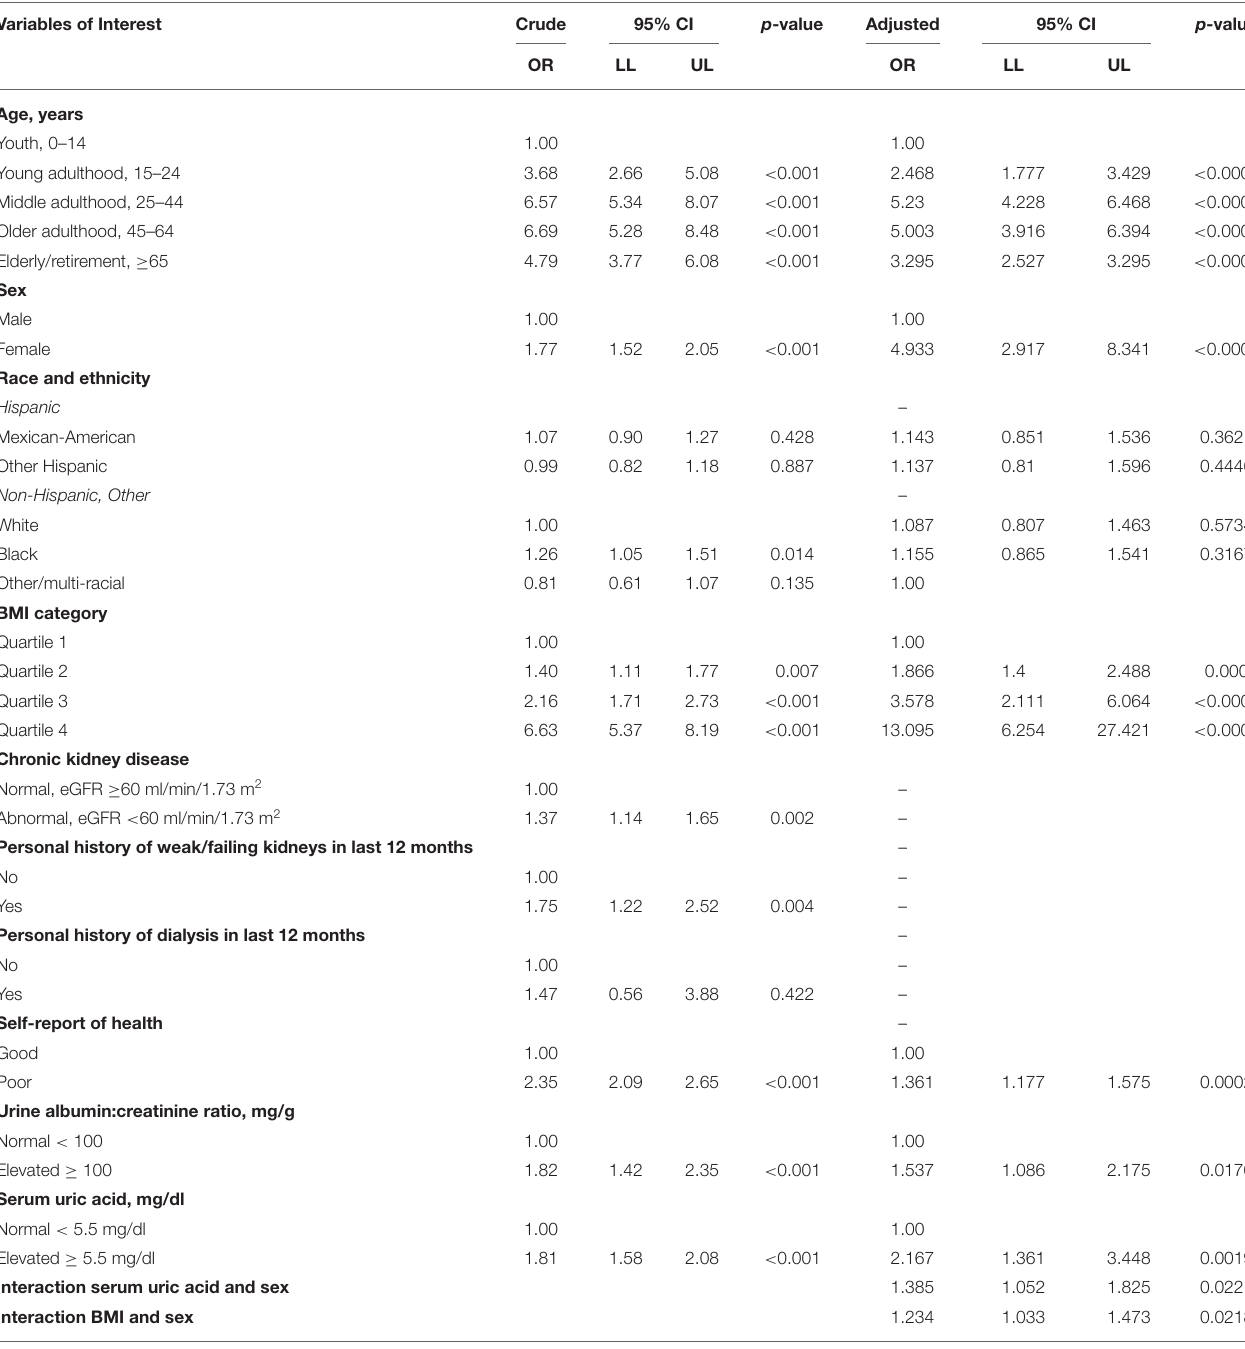
TABLE 3 | Crude and adjusted odds ratio, outcome elevated hs-CRP. Variables of Interest Crude 95% CI p -value Adjusted 95% CI p -value OR LL UL